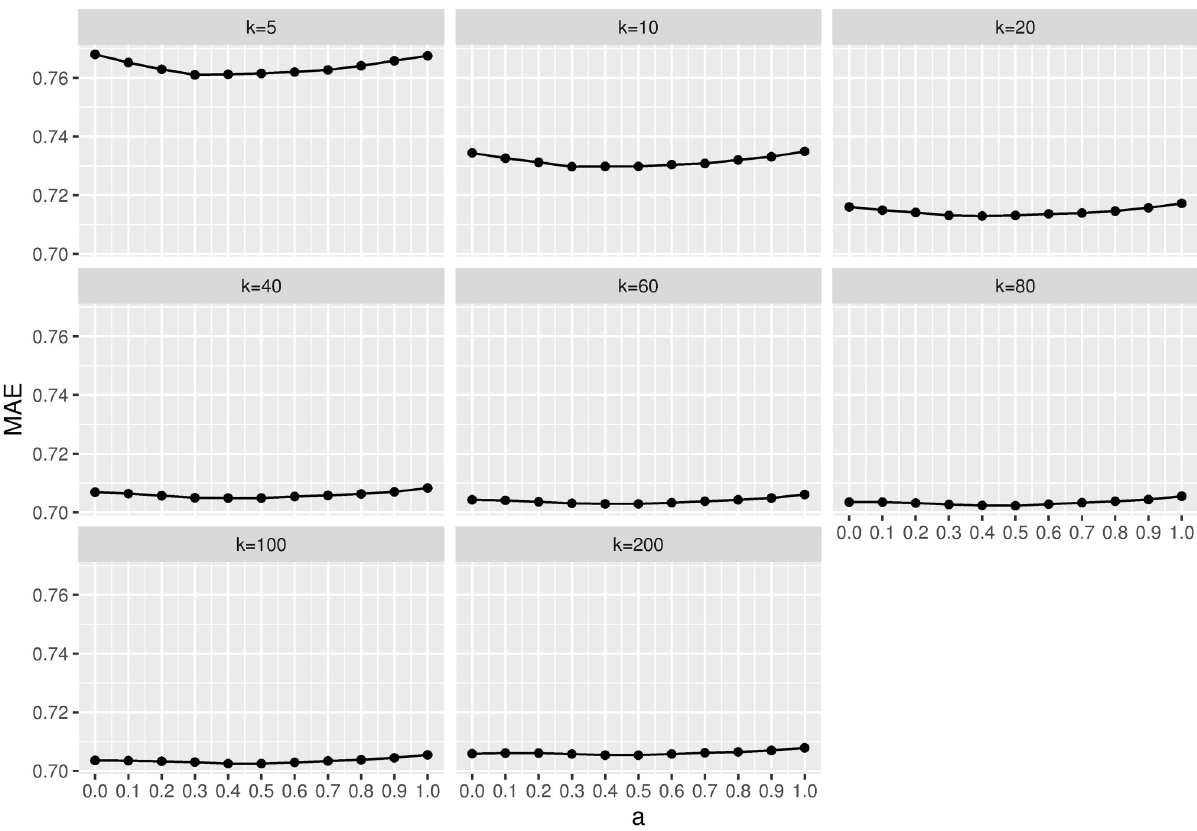
Fig 1. Experimental results of EBCR with different a values (cf. Eq (7)) for different neighbourhood sizes ( k